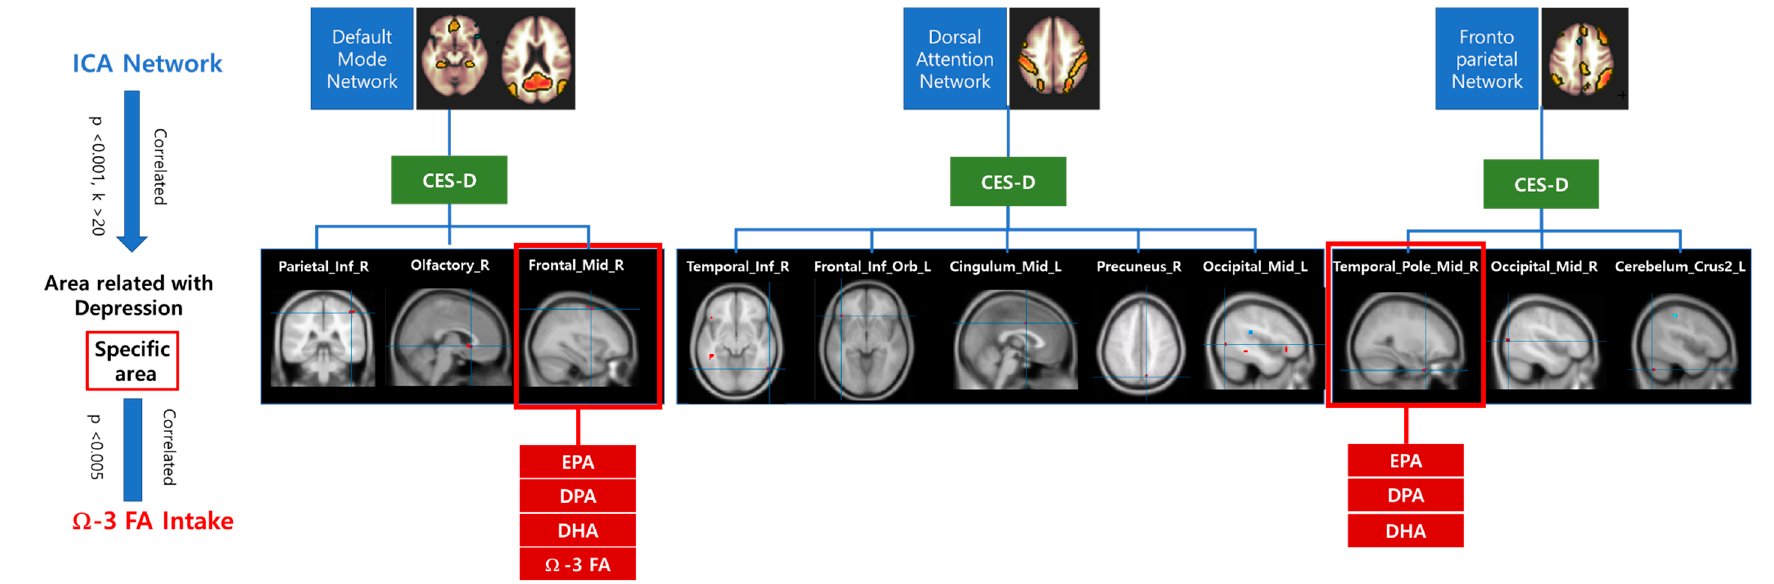
Figure 1. The beta-maps of the default mode network (DMN), dorsal attention network, and frontoparietal network were related with CES-D score. CES-D: Center for Epidemiological Studies-Depression Scale, Parietal_Inf_R: right inferior parietal, Olfactory_R: right olfactory, Frontal_Mid_R: right middle frontal cortices, Temproral_Inf_R: right inferior temporal, Frontal_Inf_Orb_L: left inferior orbital frontal, Cingulum_Mid_L: left middle cingulum, Precuneus_R: right precuneus, Occipital_Mid_L: left middle occipital cortices, Temporal_Pole_Mid_R: right middle temporal pole, Occipital_Mid_R: right middle occipital cortex, Cerebellum_Crus II_L: left cerebellar cortical crus II.